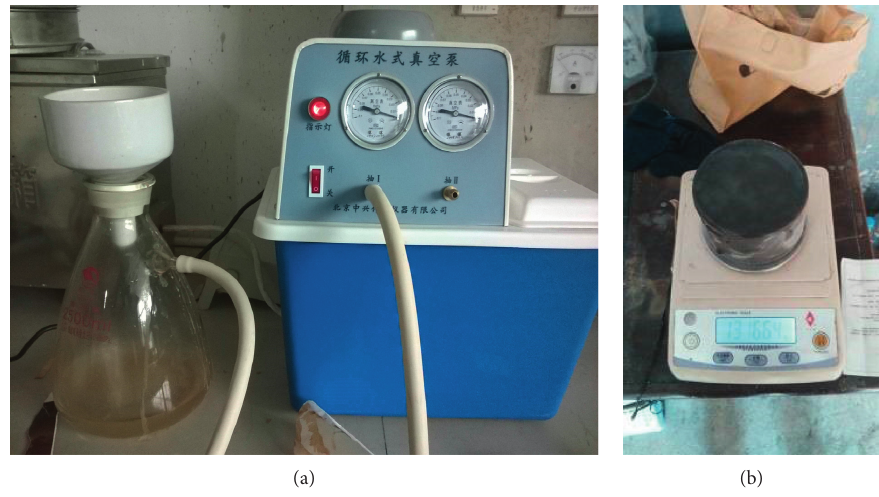
Figure 4: Detection of (a) SCOW and (b) underflow concentration.